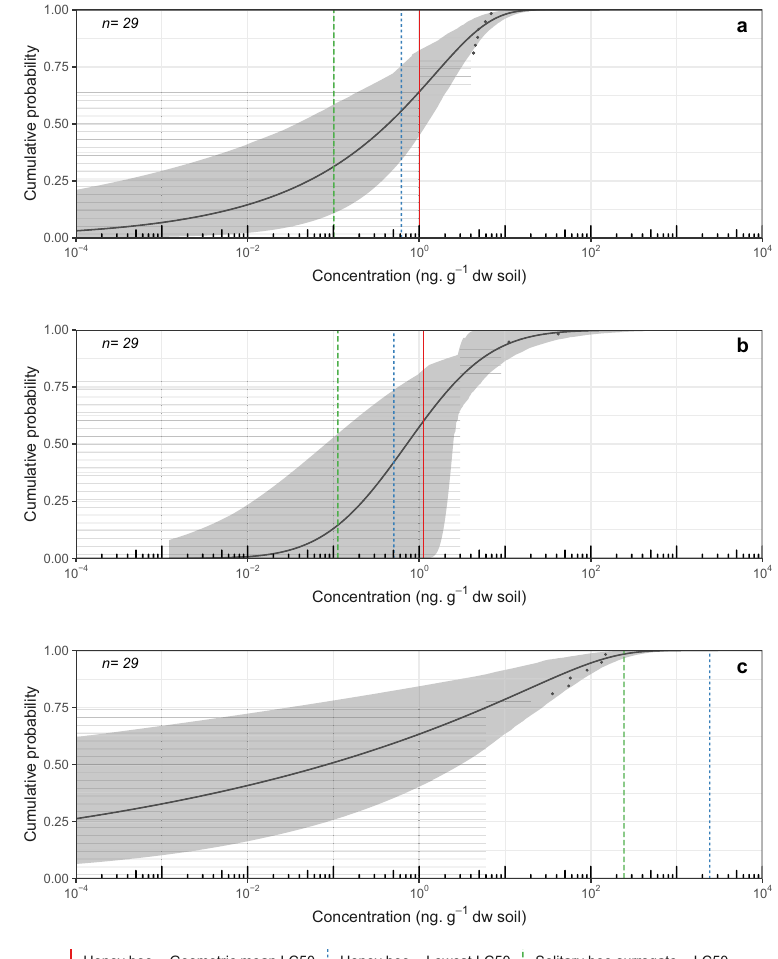
Figure 3. Environmental Exposure Distribution (EED) for chronic exposure to ( a ) clothianidin, ( b ) imidacloprid, and ( c ) chlorantraniliprole concentrations in soil samples taken from 0–15 cm depth in Cucurbita-crop fields in Ontario, 2016. Effects benchmark concentrations for chronic exposure (30 days, 33.5 g soil) for the hoary squash bee, Peponapis pruinosa (i.e. honey bee geometric mean LC 50 = red vertical line, honey bee lowest LC 50 = blue vertical dotted line, and the solitary bee surrogate LC 50 = green vertical dashed line), are represented on the EED. Exceedance of these endpoints is calculated by subtracting the cumulative probability from one. Grey horizontal lines represent individual soil samples below the analytical limits of detection or quantification, and black dots indicate samples for which insecticide residues could be quantified. The black line indicates the line of best fit to the data via maximum likelihood estimation (MLE) with associated 95% confidence intervals (grey